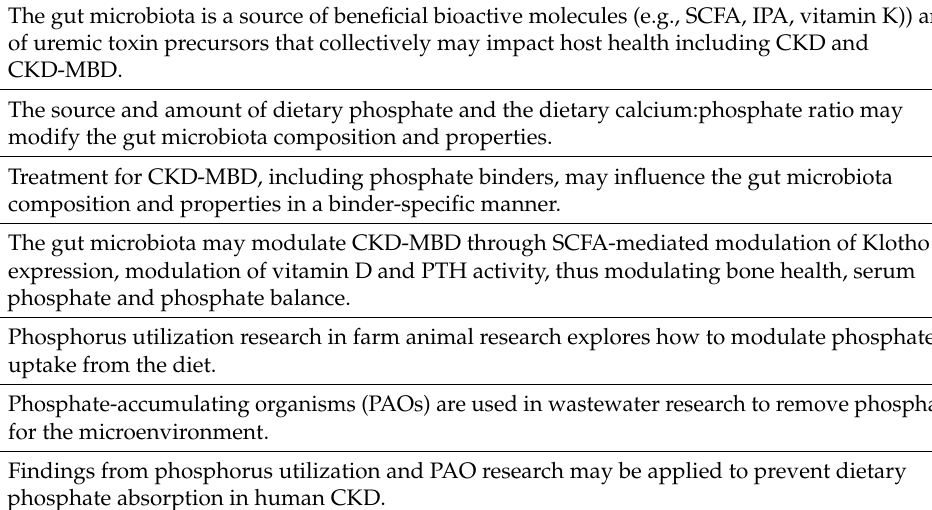
Figure 3. Interactions between dietary phosphate and the microbiota. Table 2. Key recent findings on phosphate, CKD-MBD and